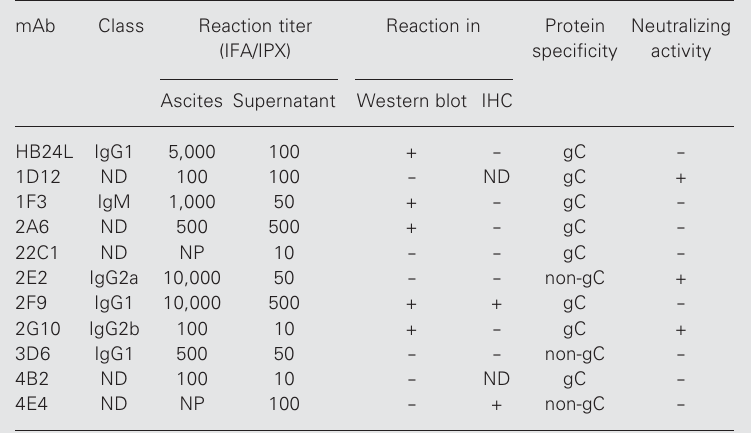
Table 1. Characterization of monoclonal antibodies (mAbs) produced against antigens of a Brazilian bovine herpesvirus type 5 (BHV-5) isolate. mAb Class Reaction titer Reaction in Protein Neutralizing (IFA/IPX) specificity